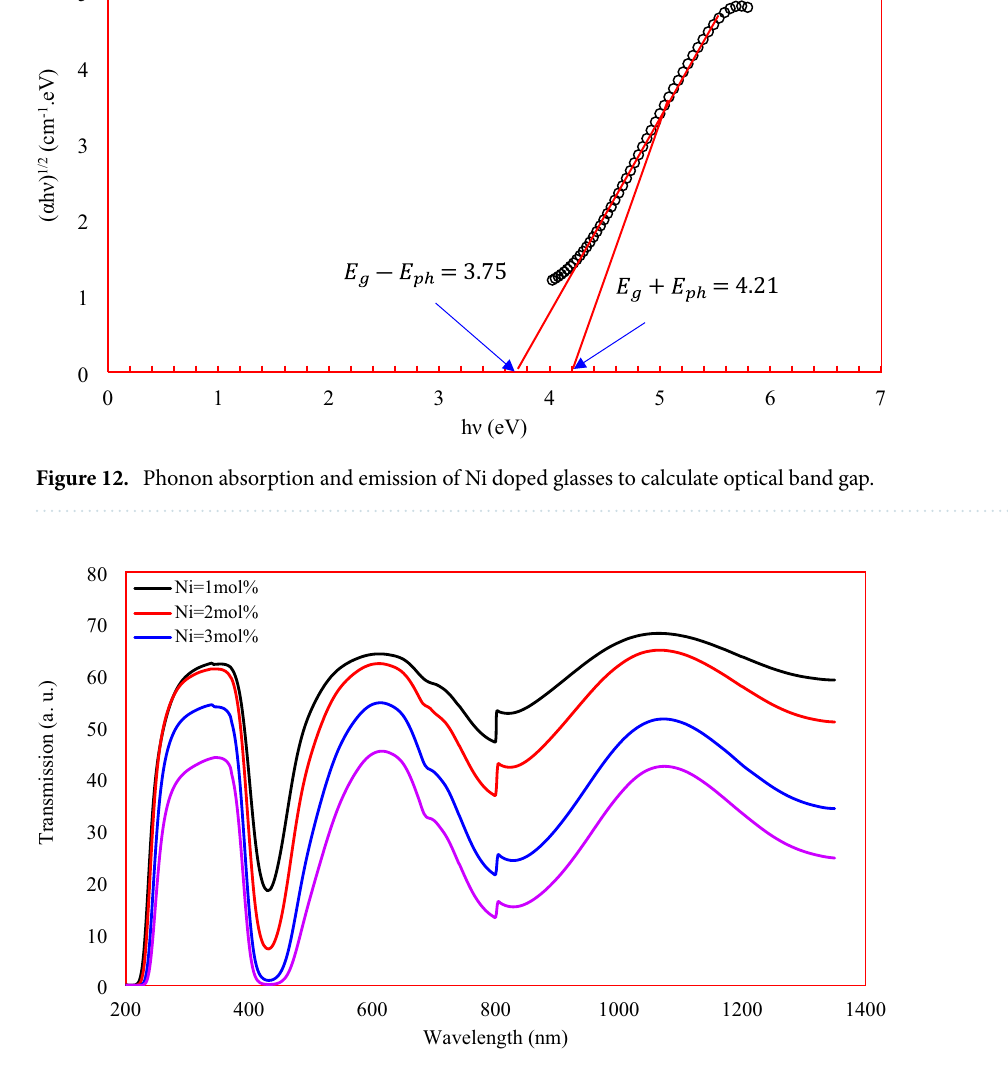
Figure 13. Optical transmittance spectra of the studied samples.